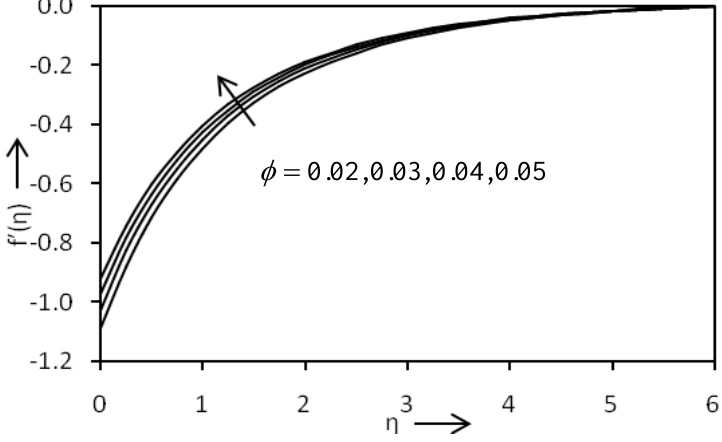
Figure 3. Variation of  on the velocity profiles with